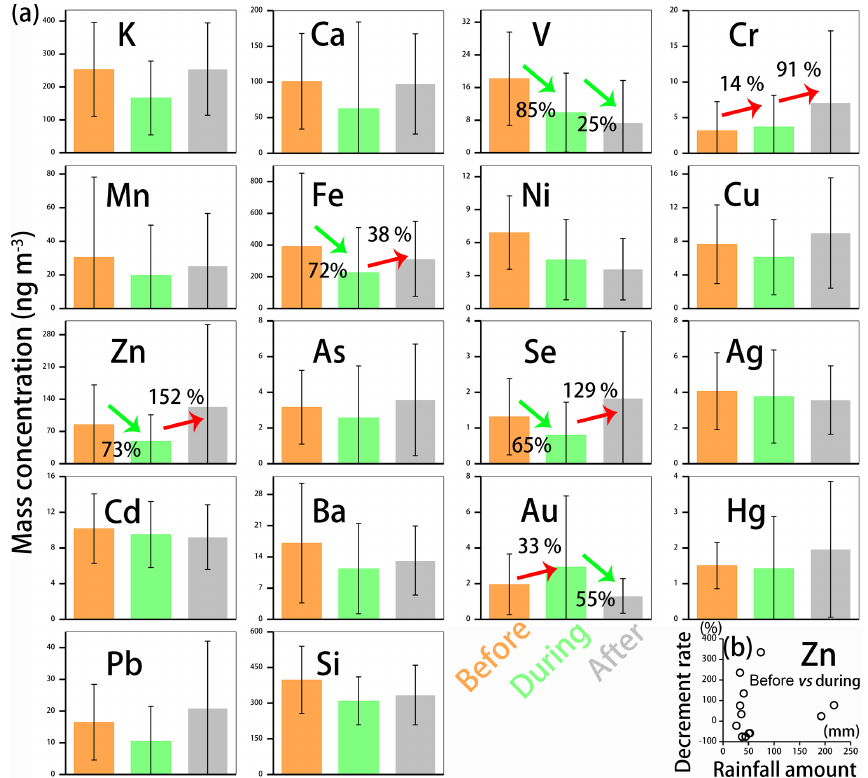
Figure 9. (a) Variation of the overall mass concentration of each elemental species before, during and after the total 12 precipitation events; (b) scatter plot of the relationship between the rainfall amount of each precipitation event and the decrease rate of the Zn concentration from the period before precipitation to the period after precipitation.